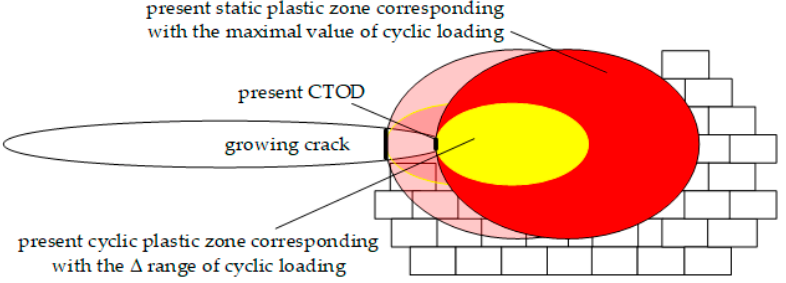
Figure 2. Schematic representation of plastic zones ahead of a fatigue crack tip with the marked Crack Tip Opening Displacement CTOD— δ .